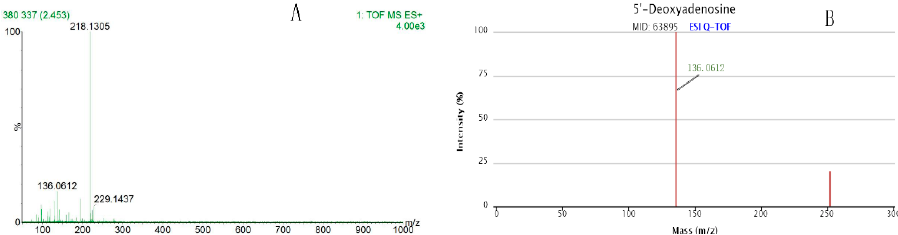
Figure 6. To confirm the compound by two stages mass spectrometry analysis. Taking the metabolite m / z 252.1095 as an example, the first stage of mass spectrometry (MS1) is 252.1095 and second stage of mass spectrometry (MS2) is 136.0612 ( A ), next to compare with the METLIN metabolomics database, the MS2 136.0612 was also appeared ( B ), and then confirmed the MS1 of this compound was 252.1095. Student’s t-test was used for statistical analysis to evaluate significant differences of endogenous metabolites. ( A ): Two stages mass spectrometry of the sample; ( B ): Two stages mass spectrometry from the